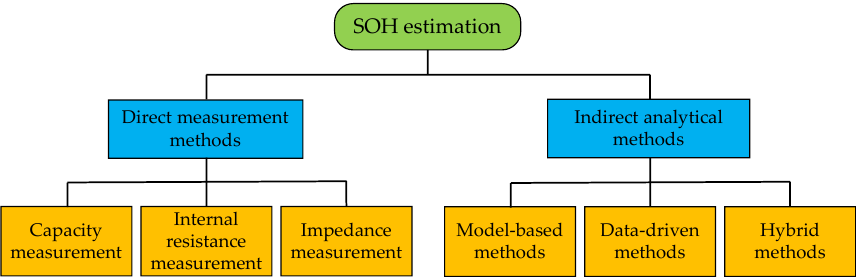
Figure 1. Classification of SOH estimation methods.